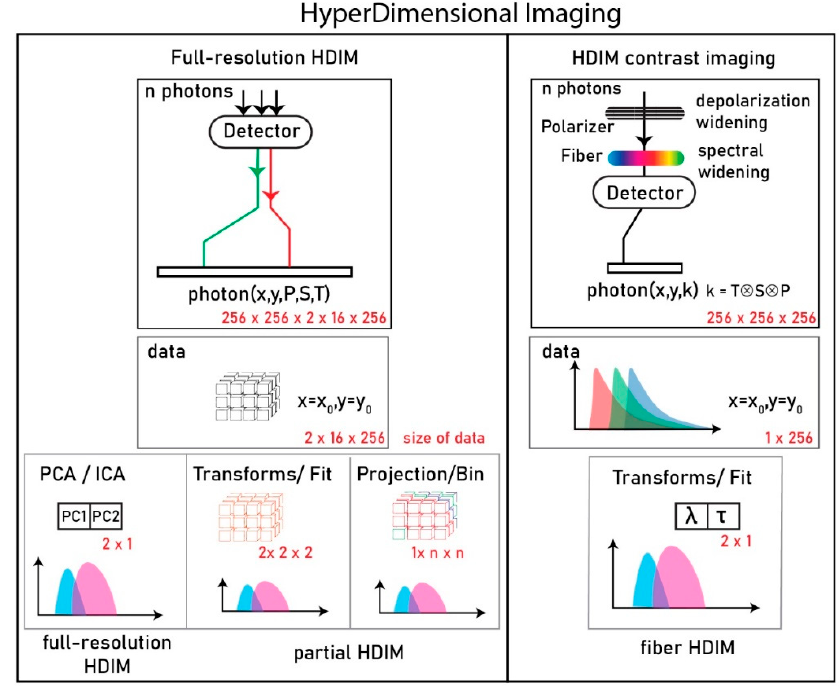
Figure 1. Representation of two different hyperdimensional imaging microscopy (HDIM) collection schemes. The left panel shows the full-resolution HDIM collection that channels multiple photons from multiple detectors through a photon counting module. Each photon is tagged with its position (x,y), polarization (P), Spectrum (S), and Time-lag with respect to excitation pulse (T). An example dataset size is shown in the red font. The data from a single-pixel (x = x0, y = y0) is a 3D distribution (size shown in red font). Three typical routines to analyze this data to achieve a dimension-reduced format shown below. PCA/ICA (principal/independent component analysis), Transforms/Fitting of the curve to derive a limited number of parameters, Projection (e.g., maximum, sum) over an axis or binning over an axis to reduce the size of data. The right panel shows the proposed method where a variable “k” encodes the Time lag (T), Spectrum (S), and Polarization (P) in a single dimension. Compared to full-resolution data, this dataset is just one-dimensional for a single-pixel and can be transformed into a contrast score of